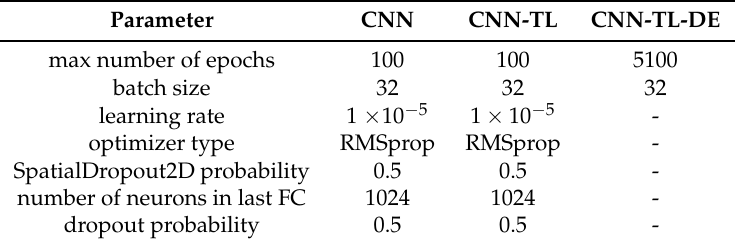
Table 2. Parameter settings for the performed experiments.